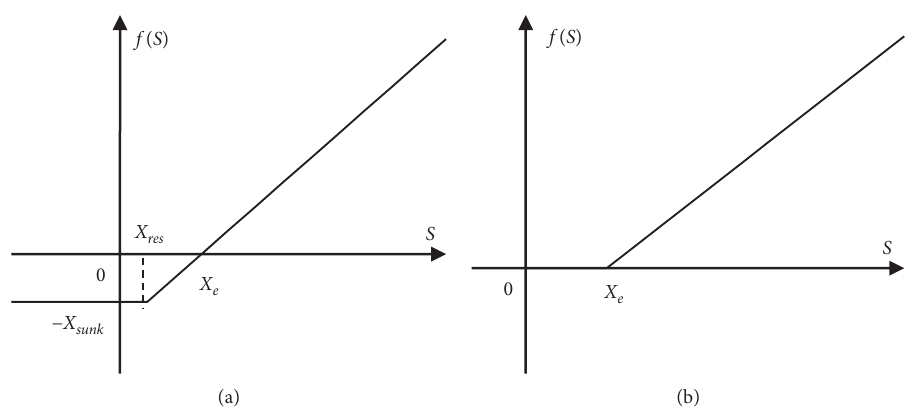
Figure 1: Intrinsic value function. (a) Real options; (b) financial call